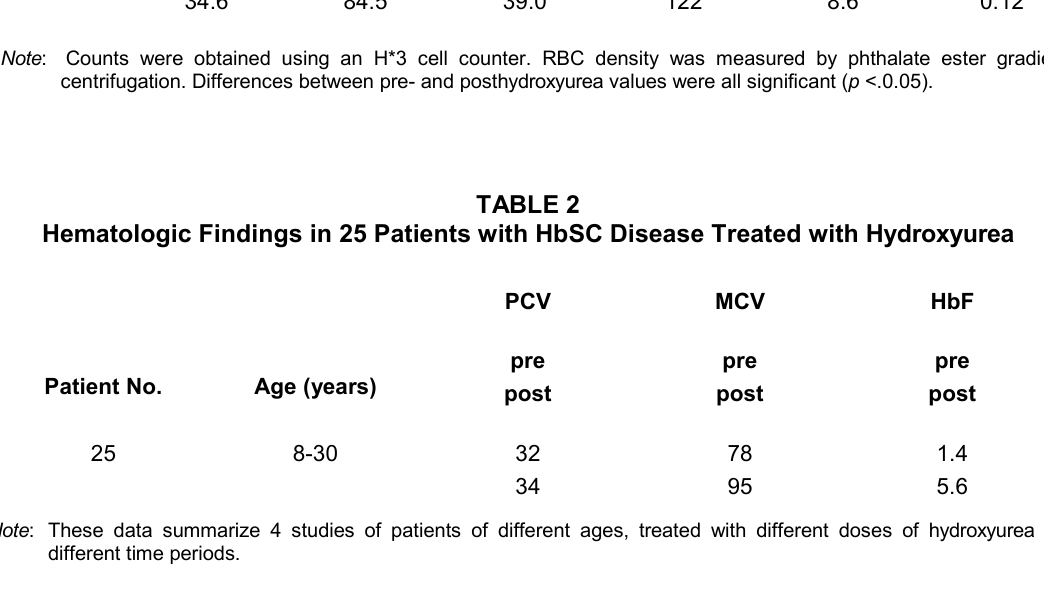
Selected Hematologic Data in Patients with HbSC Disease Treated with Hydroxyurea PCV MCV (fl) rbcHb/rHb Retic (10 9 /l) pre pre pre Patients post post post